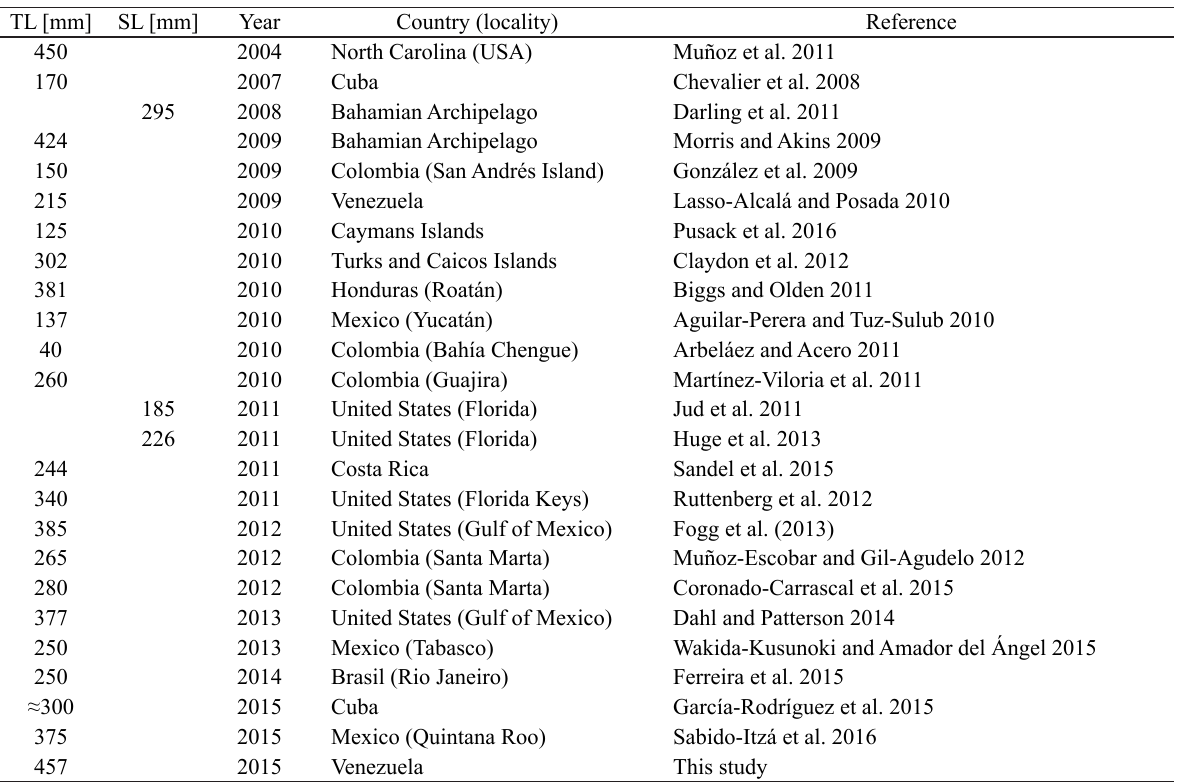
Maximum length of Pterois volitans documented for the Gulf of Mexico and the Caribbean Sea,